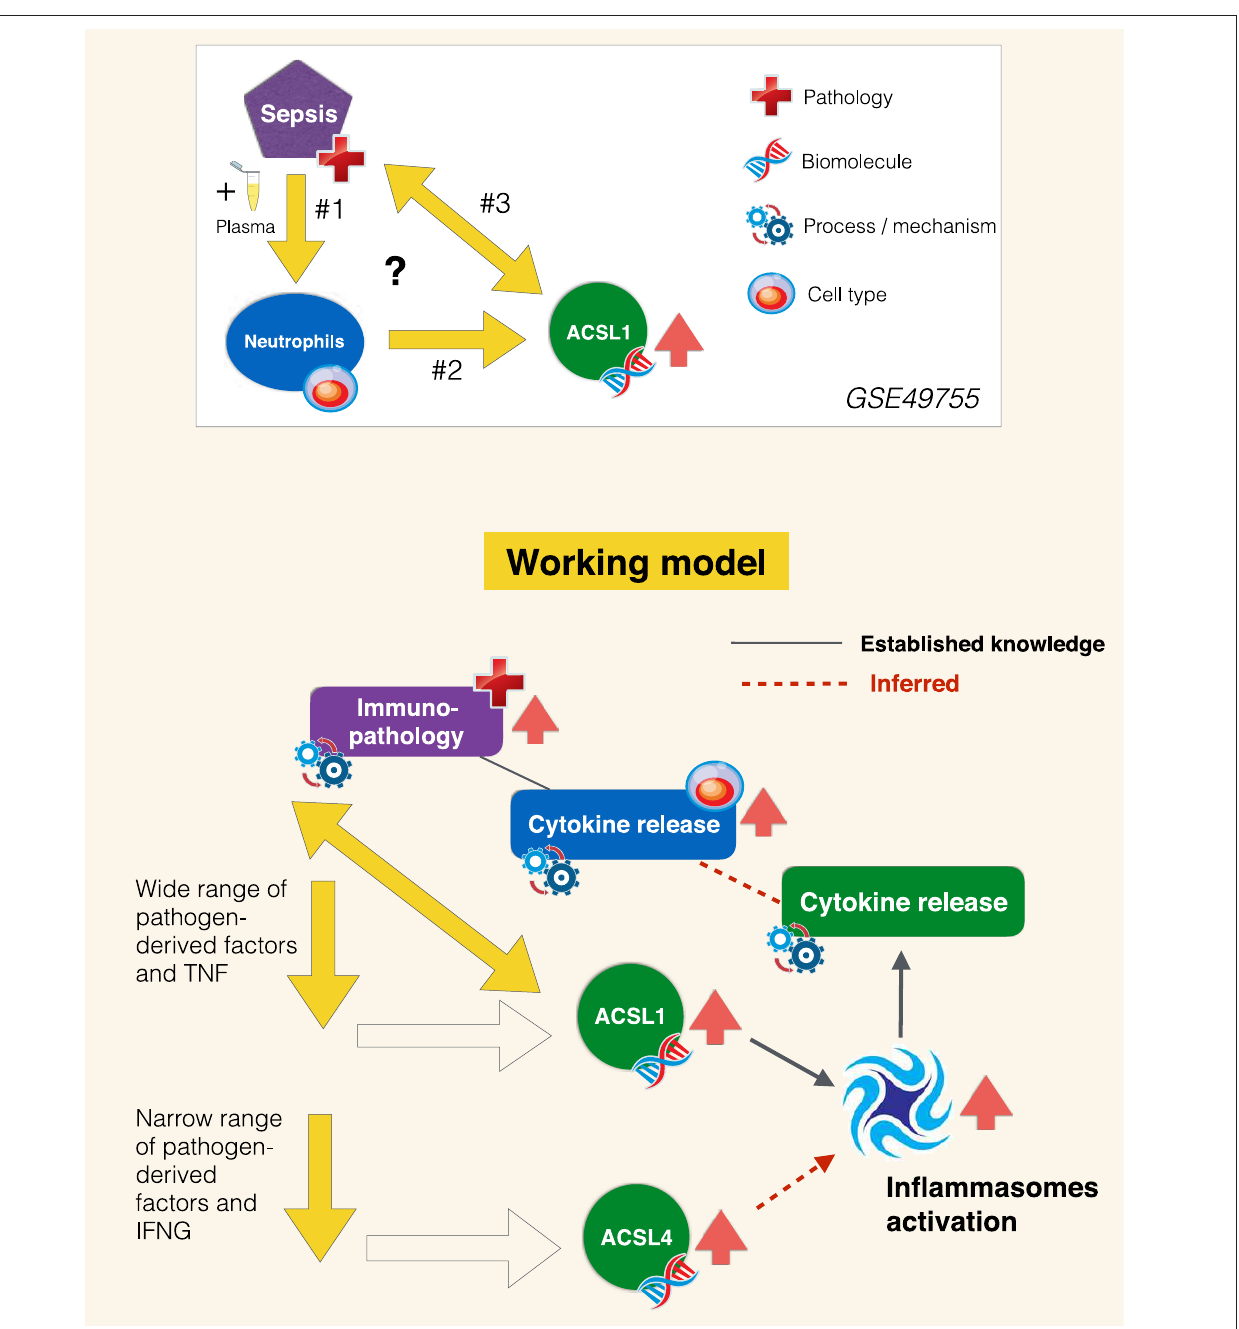
FIGURE 7 | Inferred role of ACSL1 in sepsis. The experimental context in which the increase in ACSL1 expression was initially observed is represented in the panel above (GSE49755). Open questions include: #1 What are the factors in the plasma of septic patients that induce ACSL1 expression in neutrophils? #2 Which signaling pathway is involved in regulation of ACSL1 following plasma exposure? #3 What is the role of ACSL1 in sepsis? Regarding question #1 (arrows down): briefly as suggested by the data presented on Figure 4 ACSL1 is induced in blood by a wide range of pathogen-derived factors and ACSL4 by a narrower range of factors (putatively attributed to the flagellated bacteria TLR5 agonist, flagellin). Regarding question #2 (oblique arrow): ACSL1 is known to contribute to the activation of inflammasomes in macrophages, which in turn leads to release of proinflammatory factors ( 116). Based on differential and co-expression analyses we infer that it might also be the case of ACSL4, for instance during responses to infection caused by flagellated bacteria. We also infer that ACSL-mediated inflammasome activation operates in neutrophils and also in the context of sepsis, which are also points that remain to be established. Neutrophil contribution to the cytokine storm observed during sepsis and subsequent immunopathology is well-documented. We thus assume that upregulation of ACSL1 observed during sepsis is of potential clinical relevance. An assertion that is supported by differential levels of induction observed following exposure to plasma of subject who recovered vs. those who died ( Figure 6